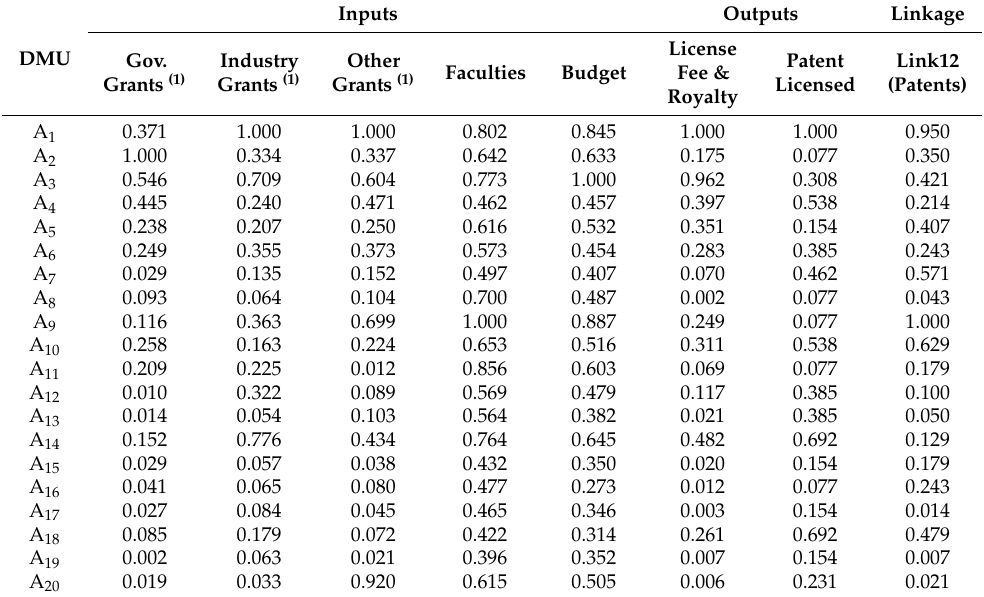
Table 8. Normalized inputs, outputs, and